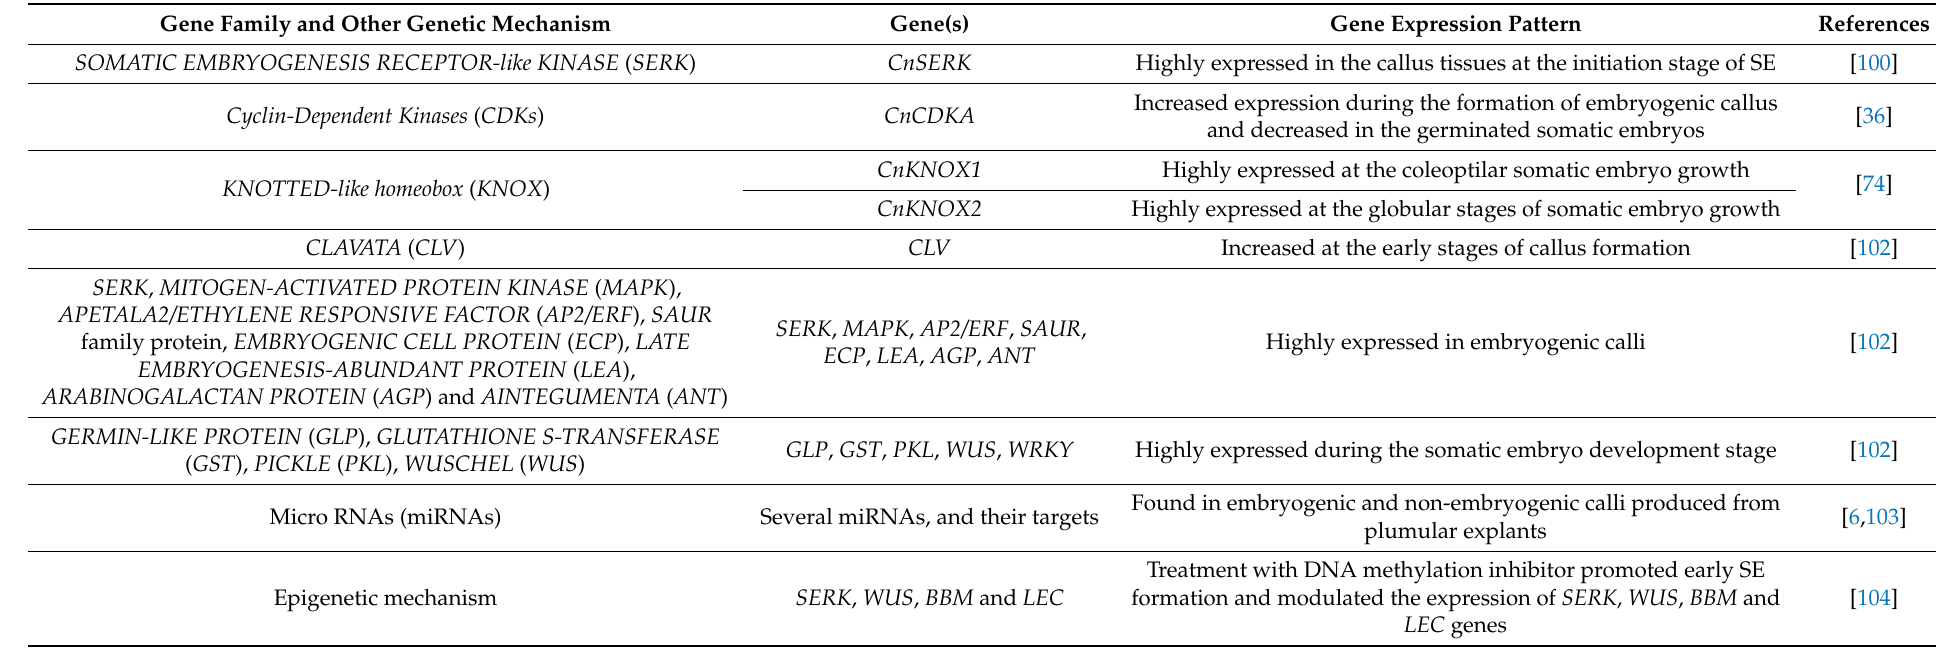
Table 2. Gene expression studies on the somatic embryogenesis of